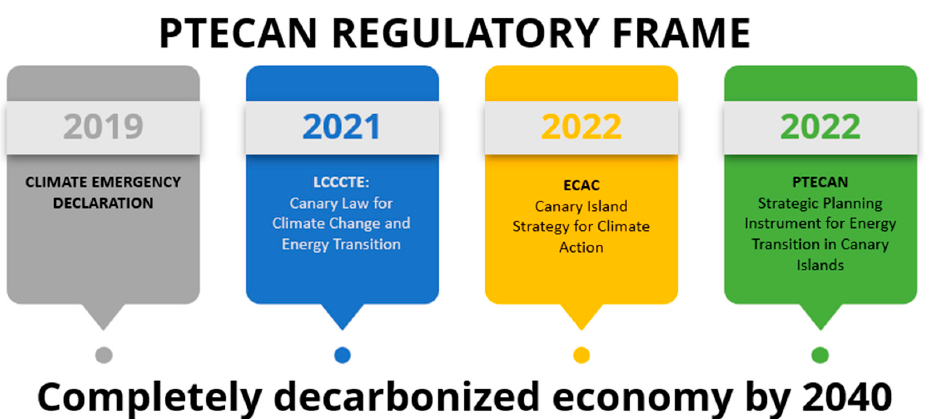
Figure 4. PTECAN Regulatory Frame. Source: Own elaboration.